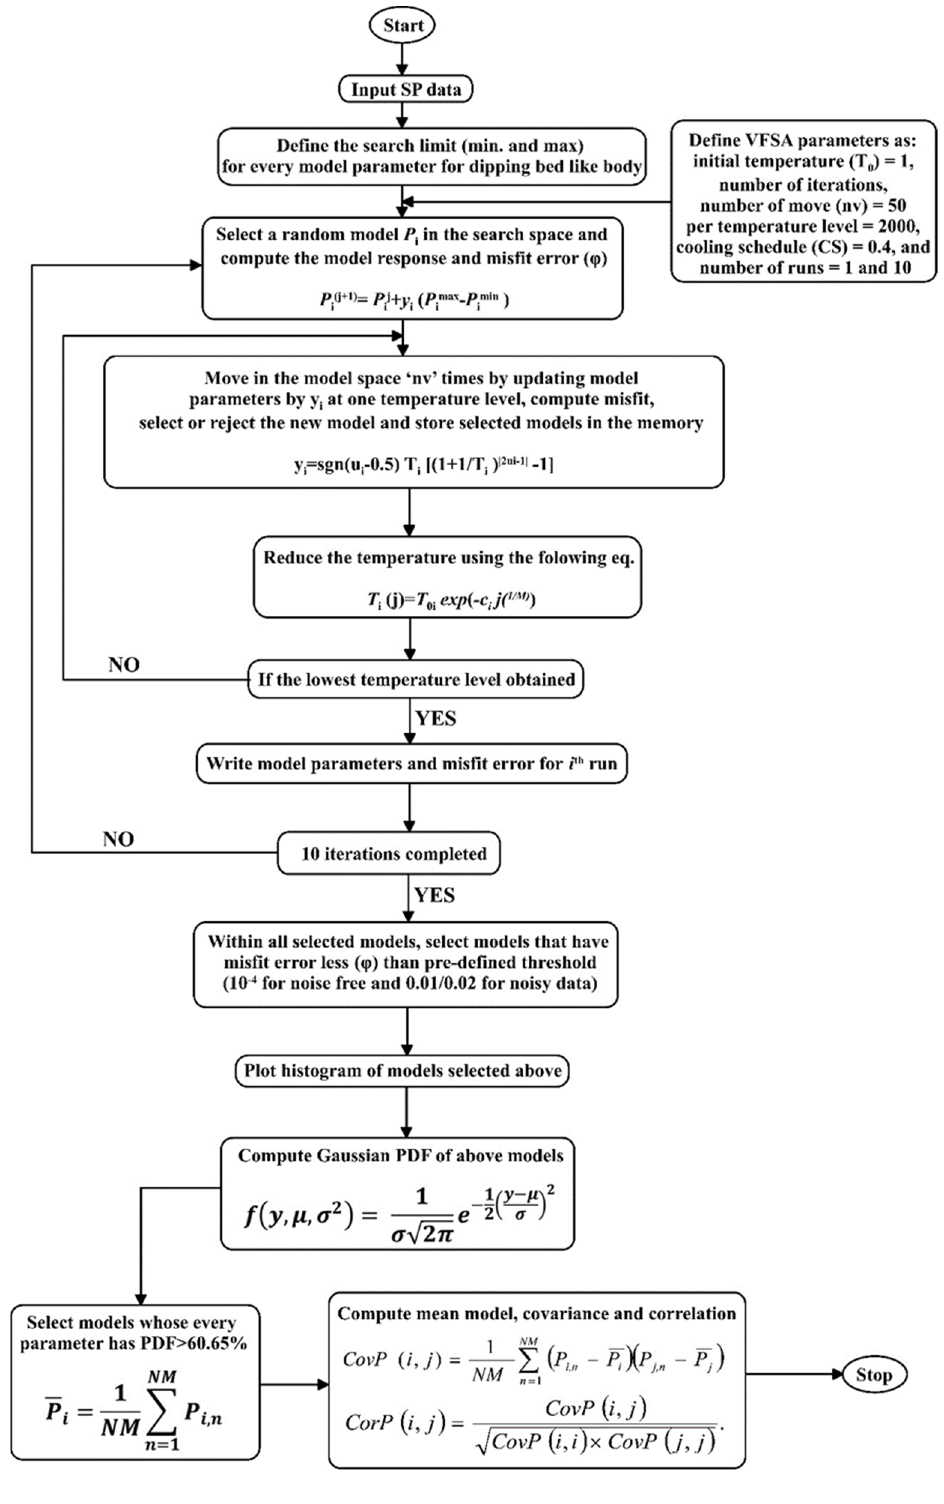
Figure 2. Flowchart of the VFSA algorithm to interpret SP data [51].